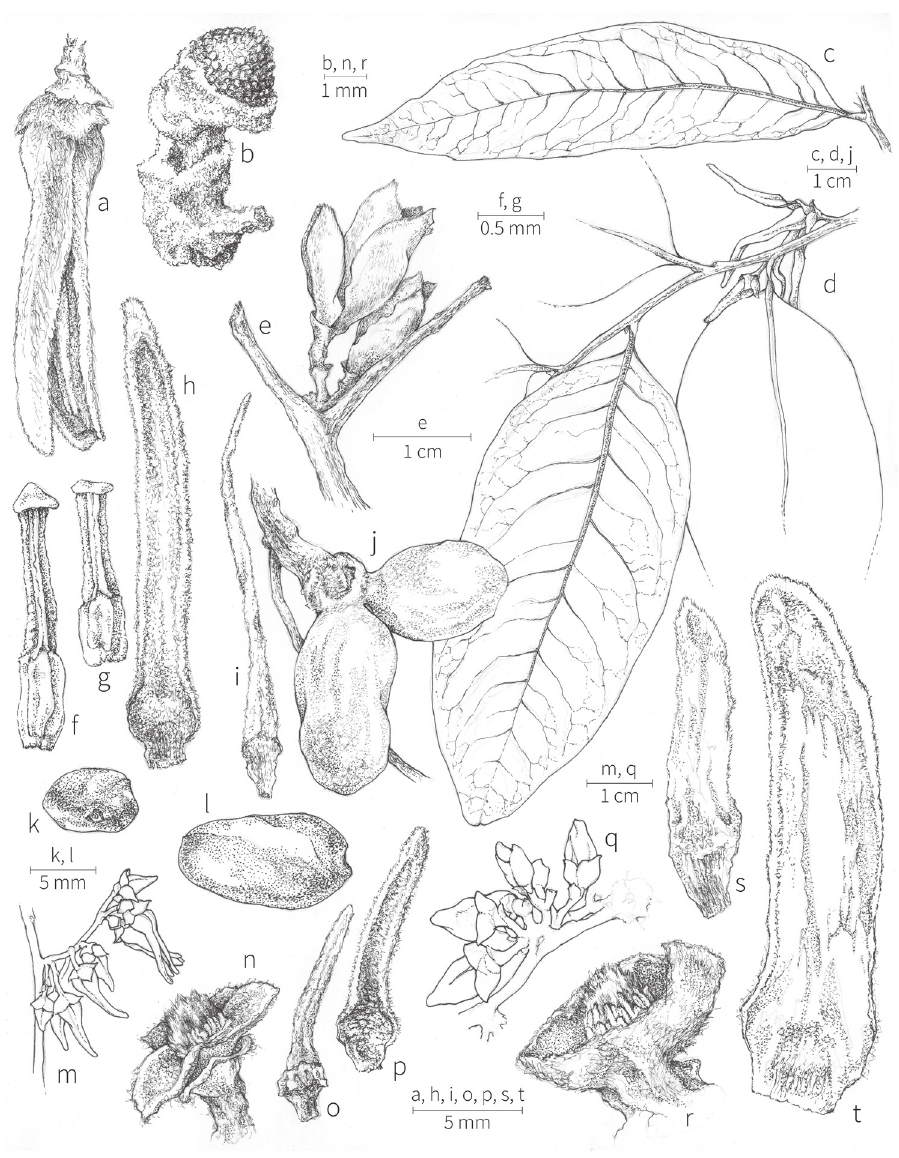
Figure 35. Xylopia phloiodora , X. paniculata , and X. calva . A–L X. phloiodora A Opening flower, lateral view B Old floral receptacle, showing staminal cone C Leaf, narrow extreme D Habit E Expanding veg- etative shoot F, G Stamens, abaxial view to show size variation H Outer petal, adaxial view I Inner petal, adaxial view J Fruit K Seed, view from micropylar end L Seed, lateral view M–P X. paniculata M Inflo- rescence N Flower with petals and stamens removed, to show staminal cone O Inner petal, adaxial view P Outer petal, adaxial view Q–T X. calva Q Inflorescence R Flower with stamens and petals removed, to show staminal cone S Inner petal, adaxial view T Outer petal, adaxial view. A, B, D, F–I from Louis 13430 (US) C from Louis 7220 (WAG) E from Tisserant 1113 (BM) J from Tisserant 1138 (P) K, L from Fay and Harris 1138 (MO) M–P from Reitsma & Reitsma 1163 (NY) Q–T from Letouzey 10306